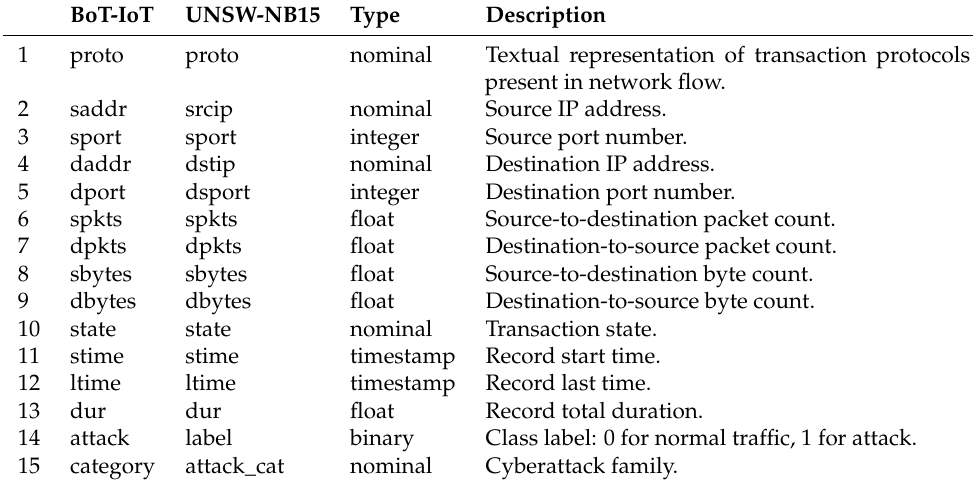
Table 7. Common features for the BoT-IoT and UNSW-NB15 datasets.